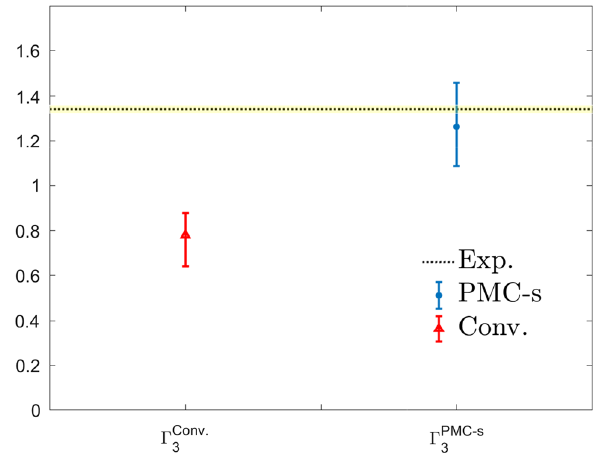
Fig. 3 The N 3 LO decay width for ϒ( 1 S ) leptonic decay versus m b Fig. 4 The N 3 LO-level ϒ leptonic decay width ( (cid:3) 3 ) under the PMC- under the PMC-s and conventional approaches. The solid line is for s and conventional scale-setting approaches, respectively. The errors PMC-s, which is independent to the choice of μ r . The error band is for are squared averages of the mentioned theoretical uncertainties. The conventional result for μ r ∈ [ 3 , 10 ] GeV, where the dashed line is for experimental value [13] is also given as a μ = 3 . 50 GeV, the lower edge is for μ = 10 GeV and the upper edge r r is for μ r = 4 . 45 GeV, respectively Table 2 The factorization scale errors (cid:9)(cid:3) 3 which are calculated by separately varying μ h , μ s and μ us by ± 10% of their center values μ μ μ h s us